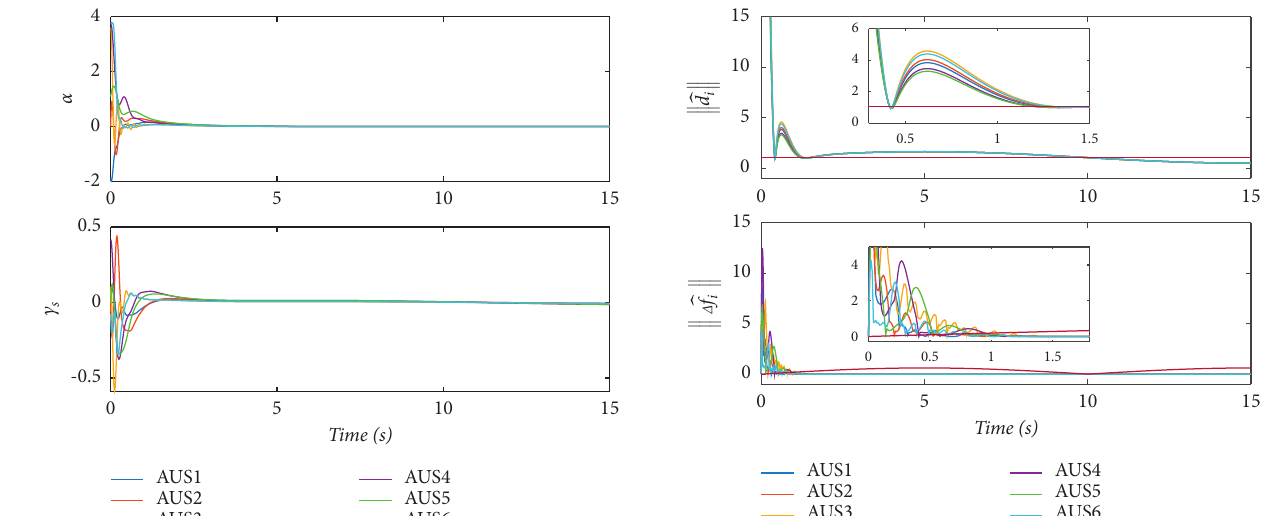
Figure 8: Trajectories of the estimation of d